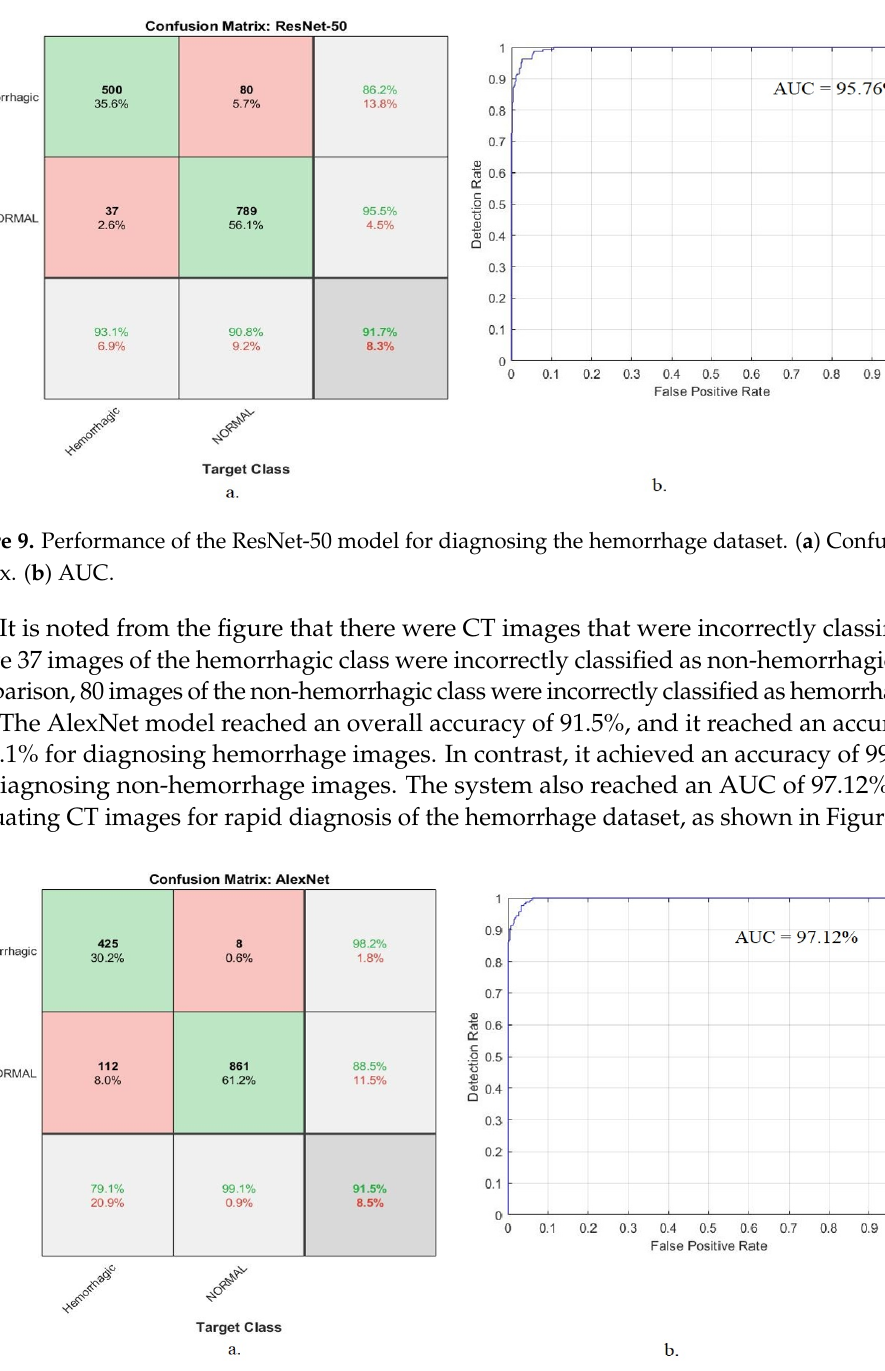
Figure 10. Performance of the AlexNet model for diagnosing the hemorrhage dataset. ( a ) Confusion matrix. ( b )